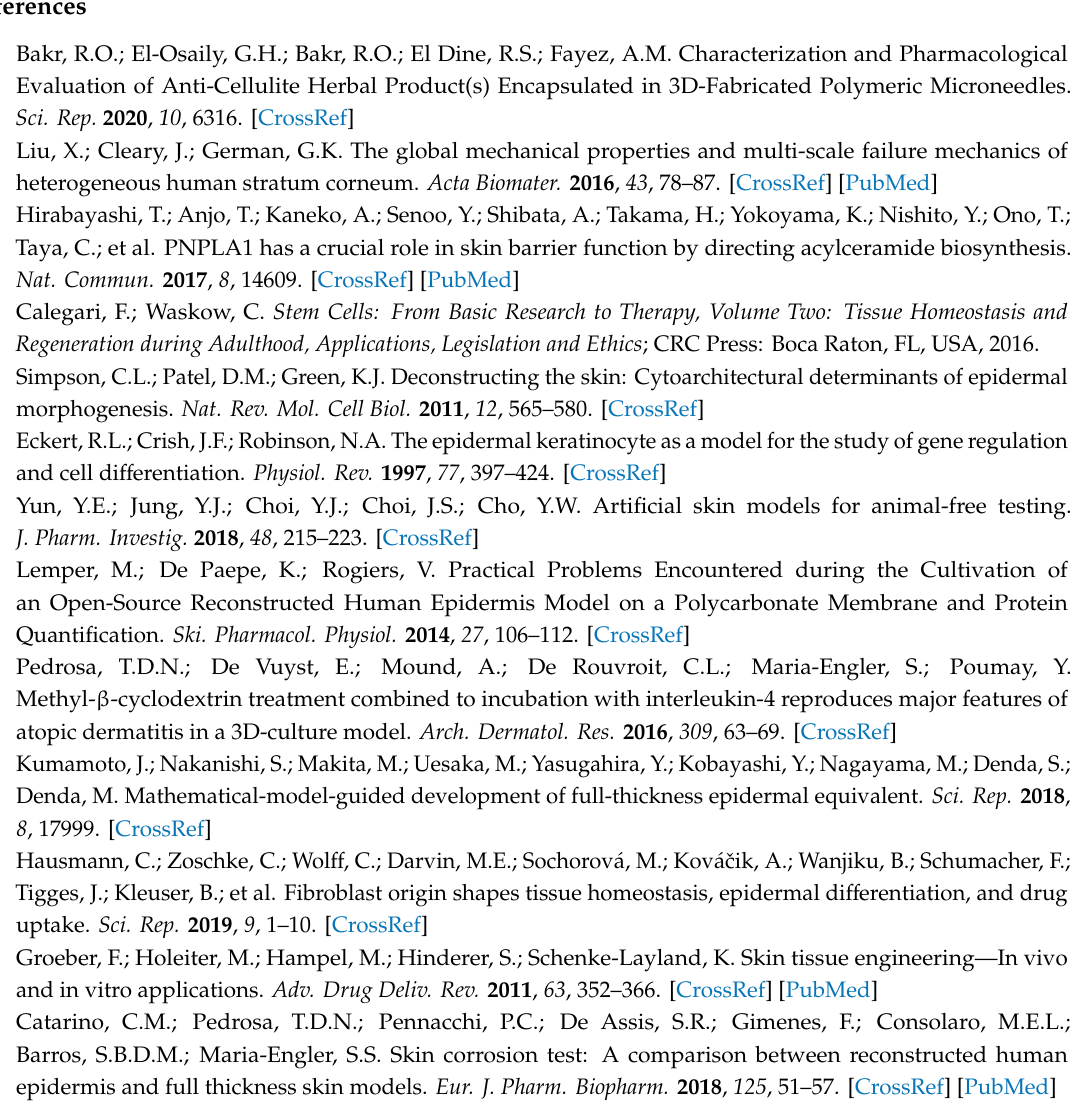
Figure S1. SEM analysis for electrospinning di ff erent PET solutions, Figure S2. SEM analysis for electrospinning di ff erent PBT solutions, Figure S3. Histogram and normal probability plot for fiber diameter analysis of PET electrospun mats, Figure S4. Histogram and normal probability plot for fiber diameter analysis of PBT electrospun mats, Figure S5. Box plot the distribution of fiber diameters analysis of PET electrospun mats, Figure S6. Box plot the distribution of fiber diameters analysis of PBT electrospun mats, Figure S7. Box plot the distribution of fiber diameters analysis of N6 / 6 electrospun mats, Figure S8: Stained human skin and RHE sections, Figure S9. Western blot analysis of the RHE samples: N-RHE and Control, Table S1. Comparison between the UN GHS category for skin irritation, N-RHE model, and control model according to OECD TG